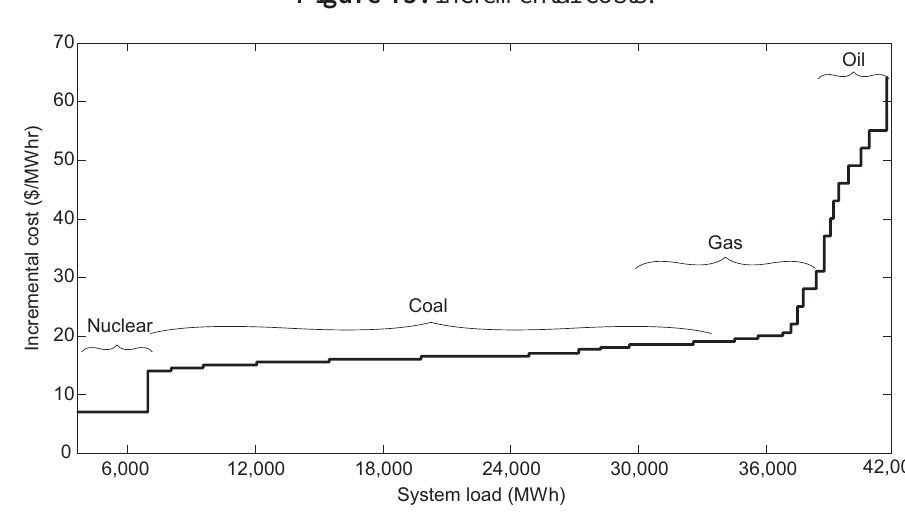
Figure 13. Incremental costs.